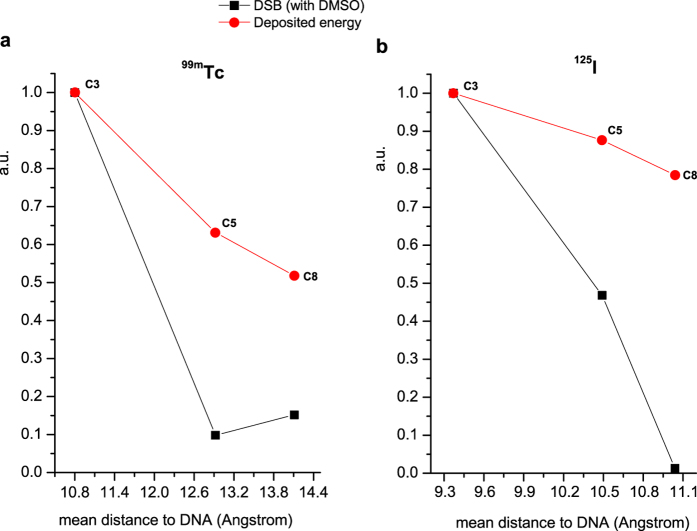
Correlation between the experimental DSB yield per decay and the calculated deposited energy: (a) 99mTc(I) complexes and (b) 125I-labelled derivatives. All values are normalized to their maximum values.